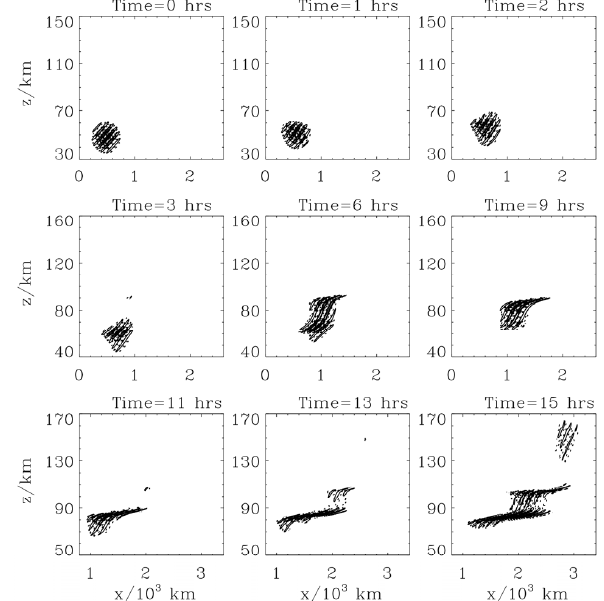
Fig. 2. Temporal evolution of the normalized horizontal perturbation velocity. The minimum values and intervals of the contours are, respectively, 0.1 and 0.2. The maximum absolute values are, respectively, 1.00, 1.45, 2.08, 2.72, 3.11, 6.71, 8.10, 7.88, and 5.62ms − 1 from 0 to 15h at different times.